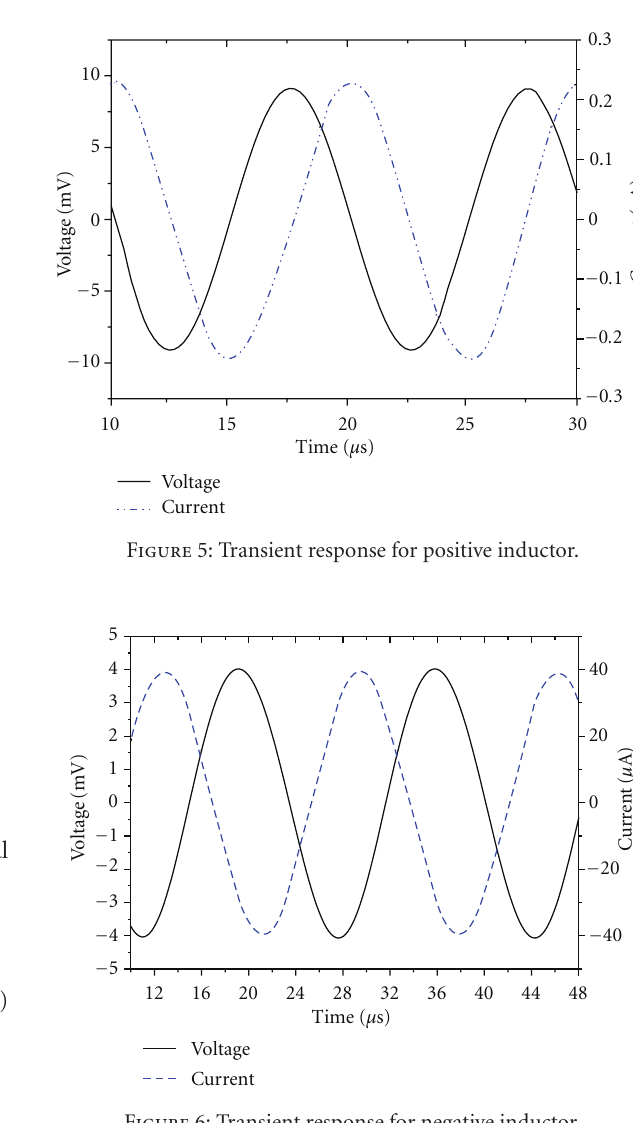
Figure 6: Transient response for negative